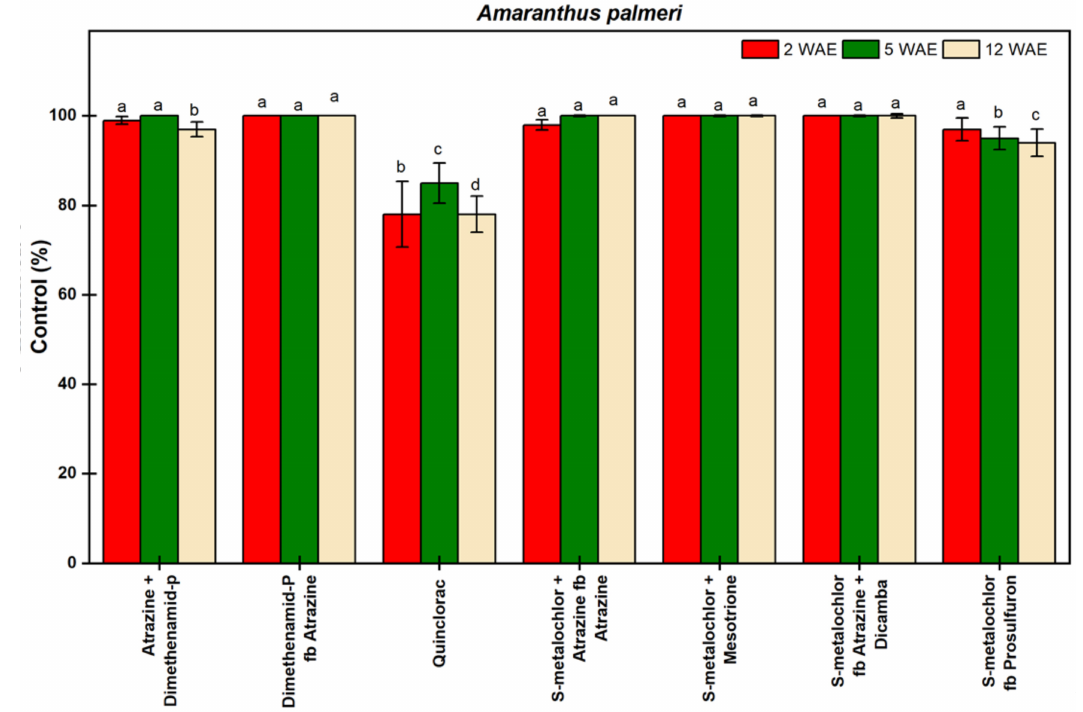
Figure 3. Amaranthus palmeri control with di ff erent herbicide treatments at 2, 5, and 12 weeks after emergence (WAE). Data were analyzed separately for each WAE. Data were pooled over three years. The same letters on bars indicate no significant di ff erences at p < 0.05, according to Fisher’s least significant di ff erence